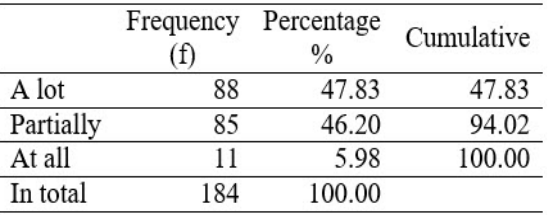
Table 1. Results of statistical analysis of question 1.